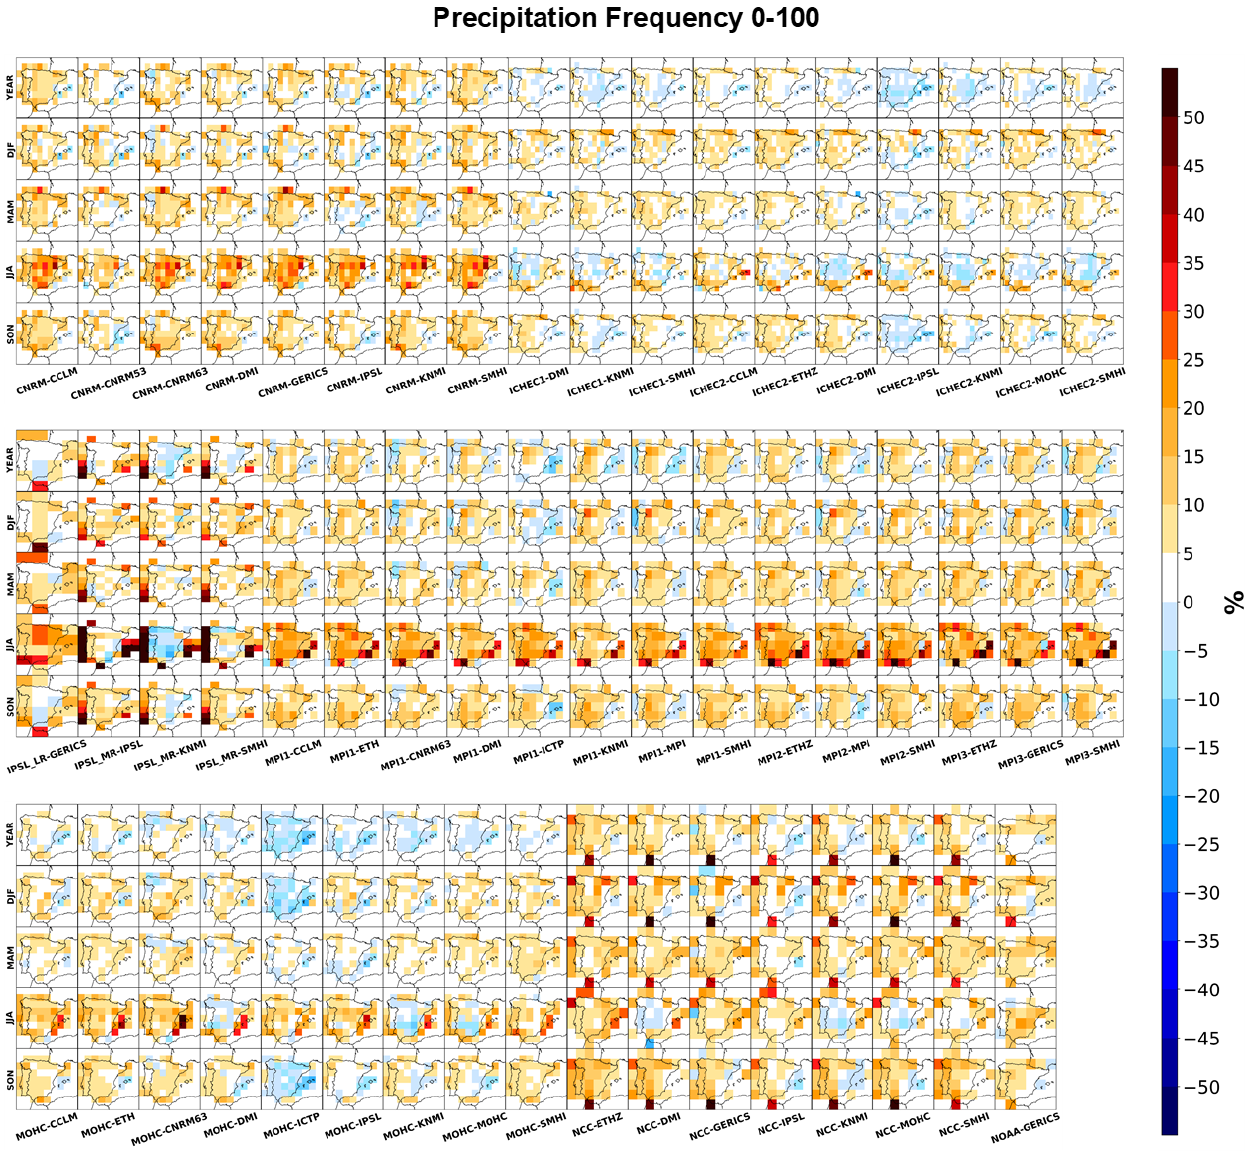
Figure 6. Yearly and seasonal distribution added values (DAVs) of the Iberian Peninsula for the historical (1971–2005) EURO-CORDEX RCMs, with the IGD as a reference for the daily precipitation frequency, considering the whole PDF. All RCM data were previously inter- polated to 0.1 ◦ regular resolution from the observations, while the observations were interpolated into each CMI5 GCM